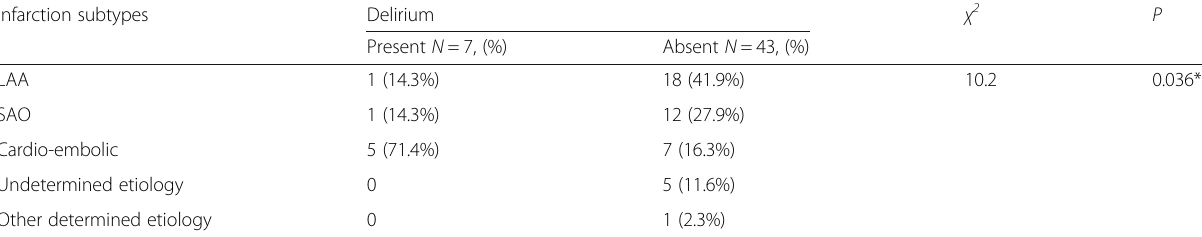
Table 4 Relationship between incidence of delirium and infarction subtypes in studied ischemic stroke patients according to TOAST criteria Infarction subtypes